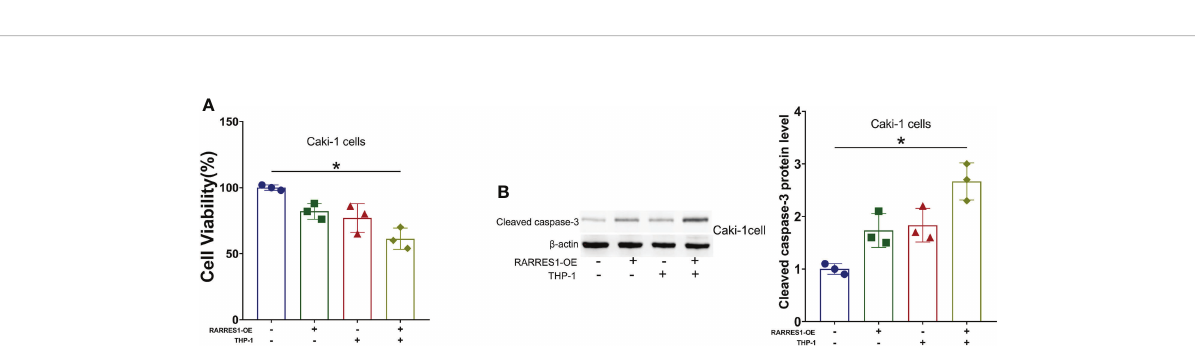
FIGURE 9 RARRES1-overexpressing RCC cell-induced M1 macrophages reduce the viability, induce the apoptosis and suppress the proliferation of renal carcinoma cells. (A) Cell viability was evaluated by a CCK-8 assay. (B) The level of an apoptosis-related protein (cleaved caspase-3) was measured by Western blot analysis. *p <